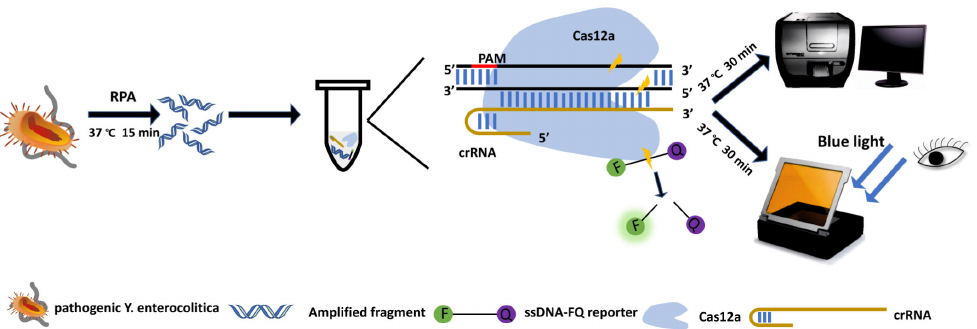
Figure 1. Schematic of CRISPR/Cas12a-RPA system showing extraction of the crude genomic DNA (boiling/centrifugation), RPA (37 °C, 15 min), Cas12a collateral cleavage reaction (37 °C, 30 min), and observation of the signal (blue light, or microplate reader).